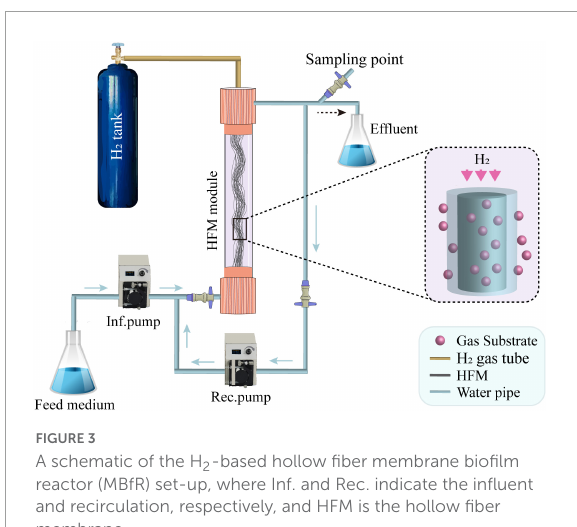
FIGURE3 A schematic of the H 2 -based hollow fiber membrane biofilm reactor (MBfR) set-up, where Inf. and Rec. indicate the influent and recirculation, respectively, and HFM is the hollow fiber membrane.